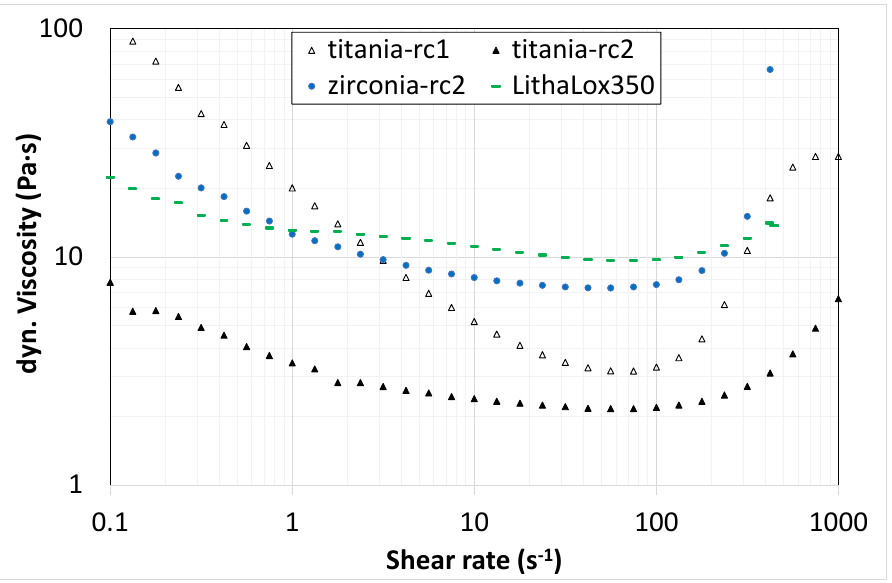
Figure 4. Dynamic viscosity of various titania (triangles) and zirconia (circles) suspensions compared to a commercial suspension (Lithalox 350) .